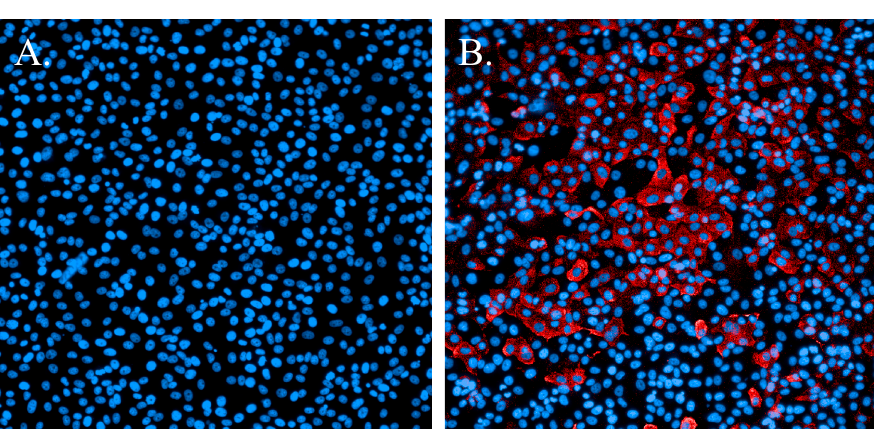
Figure 2. Immunofluorescence staining of SARS-CoV-2-infected cells. ( A ). Non-infected cells stained with Hoechst nuclear stain (blue). ( B ). Cells infected with SARS-CoV-2 and probed with a SARS-CoV N-protein-specific antibody and Alexa594 secondary antibody (red). Cells were counterstained with Hoechst nuclear stain